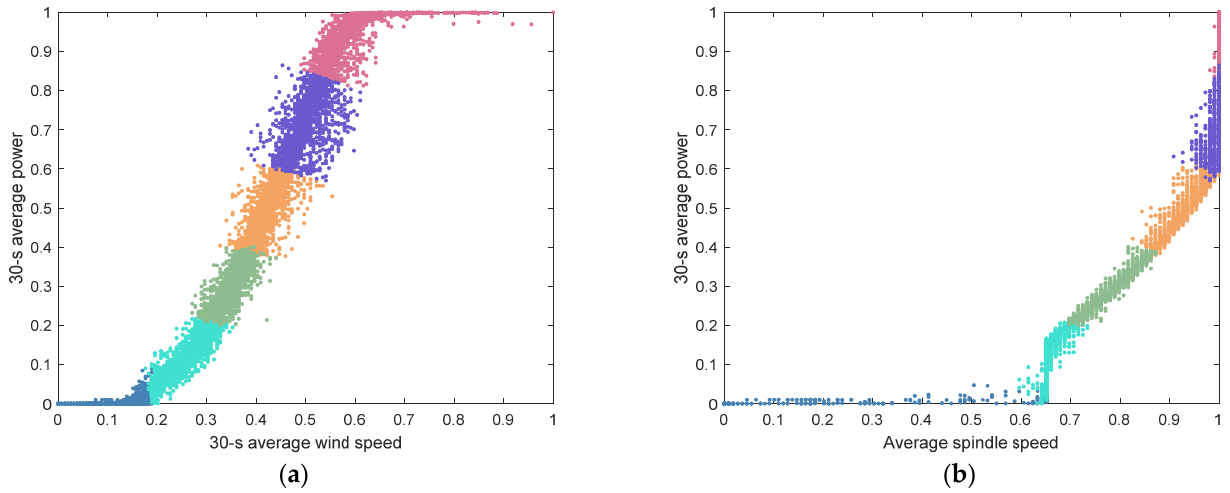
Figure 8. Direct classification of working conditions using the k -means clustering algorithm. ( a ) 30-s average wind speed vs.